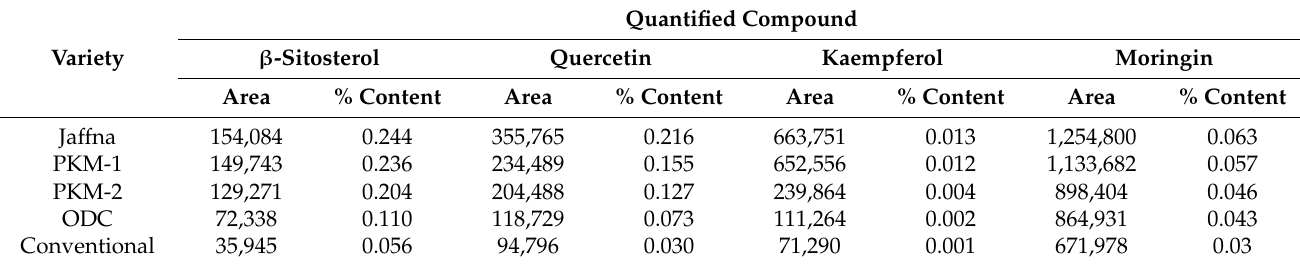
Table 2. HPLC analysis of selected compounds reported in